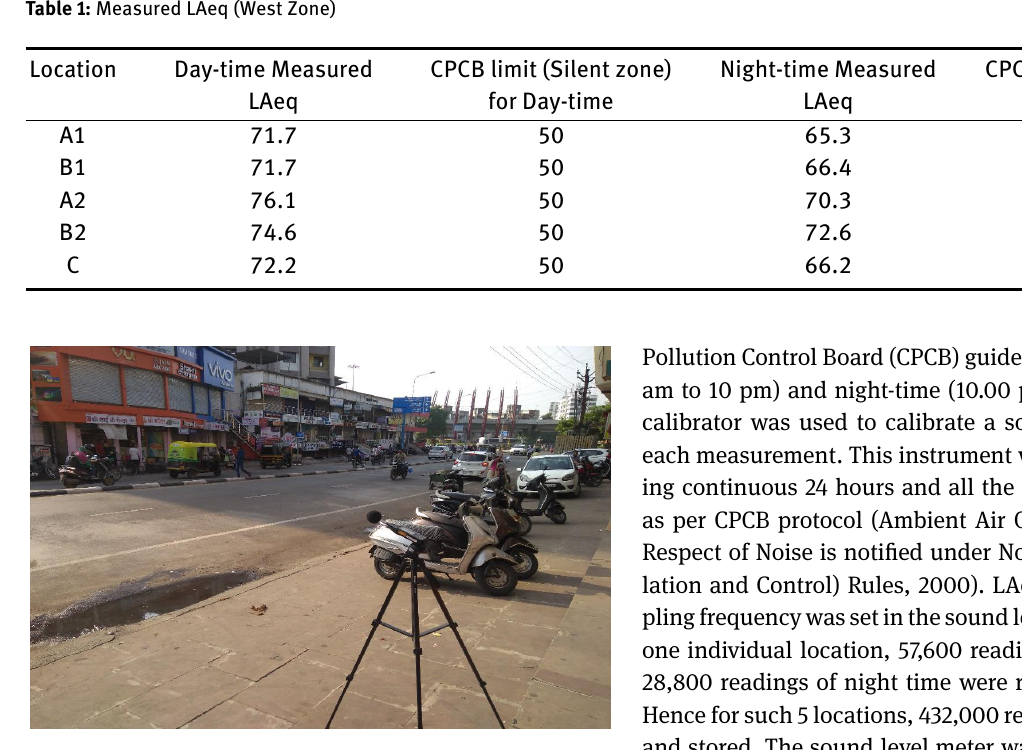
Figure 5: View of location 3-A 2